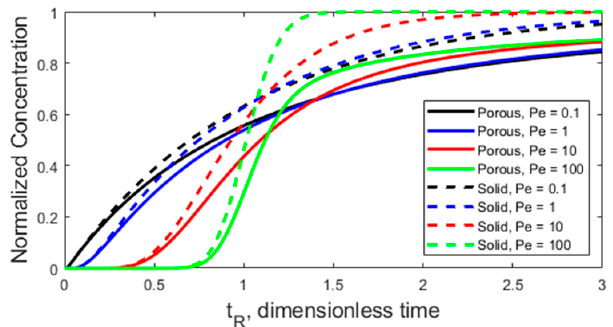
Figure 2. The e ff ect of the Peclet Number on the e ffl uent concentration profile for solid and porous Figure 2. The effect of the Peclet Number on the effluent concentration profile for solid and porous Figure 2. The effect of the Peclet Number on the effluent concentration profile for solid and porous fibers ( 𝐷 (cid:3019) = 0.1,𝐵 (cid:3040) = 10,𝛾 = 1,𝛷 = 0,𝜀 (cid:3033) = 0.8 ). fibers ( D R = 0.1, B m = 10, γ = 1, Φ = 0, ε f = 0.8). fibers ( 𝐷 (cid:3019) = 0.1,𝐵 (cid:3040) = 10,𝛾 = 1,𝛷 = 0,𝜀 (cid:3033) = 0.8 ).